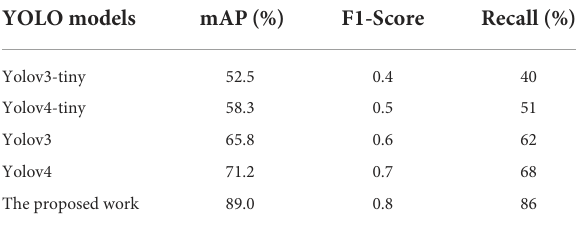
TABLE 2 The detection performance for different convolutional weights.